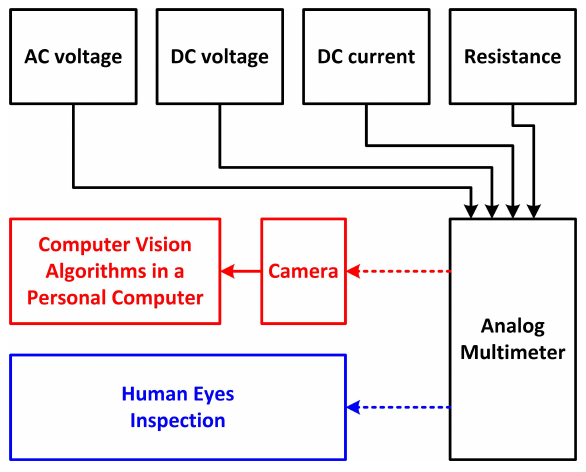
Figure 3. Framework of this